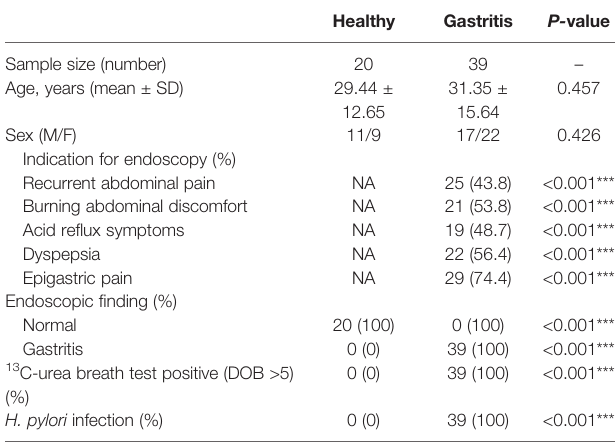
TABLE 1 | Characteristics of healthy controls and gastritis patients.